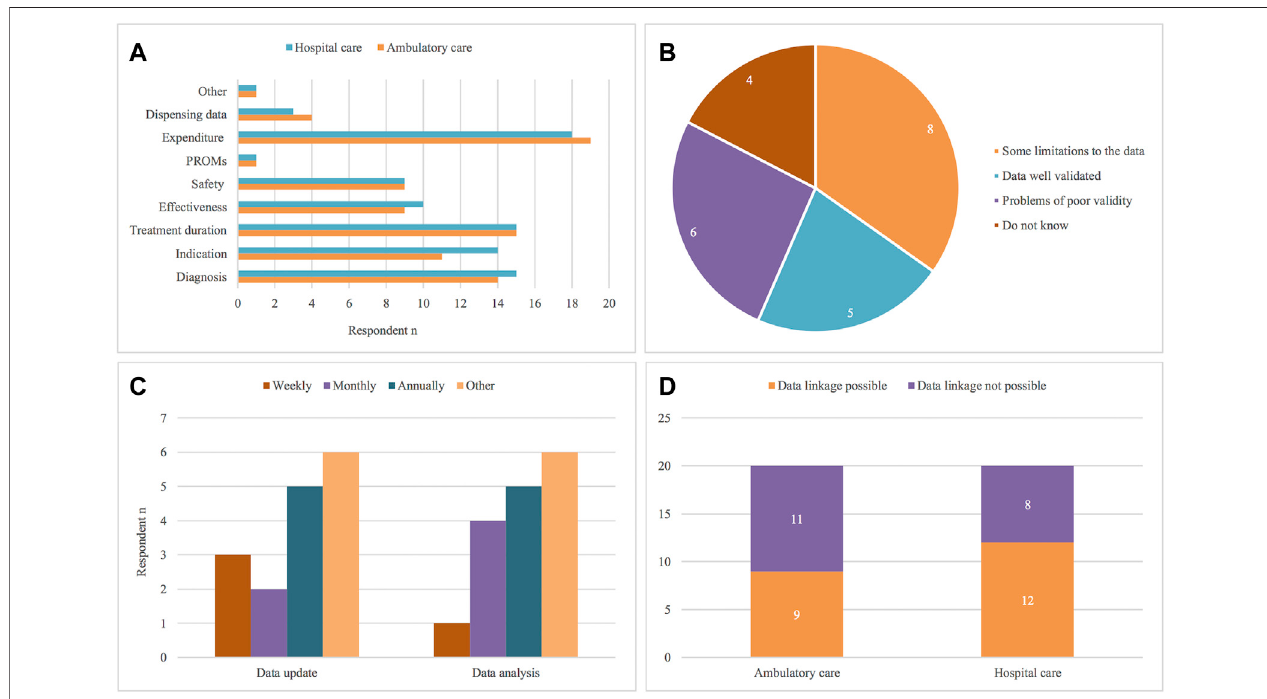
FIGURE 4 | Types of oncology data recorded ( (A) , n = 24), perceived data robustness and validity ( (B) , n = 23), frequency of data update and analysis ( (C) , n = 22) and possibilities for data linkage ( (D) , n = 22), according to the participants. PROMs = Patient Reported Outcome Measures.